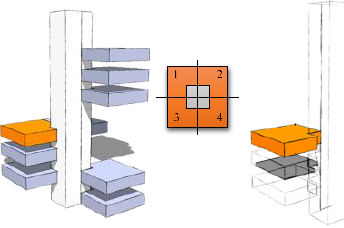
Fig. 3. Model for analysing: a conceptual housing unit, no orientation impact.